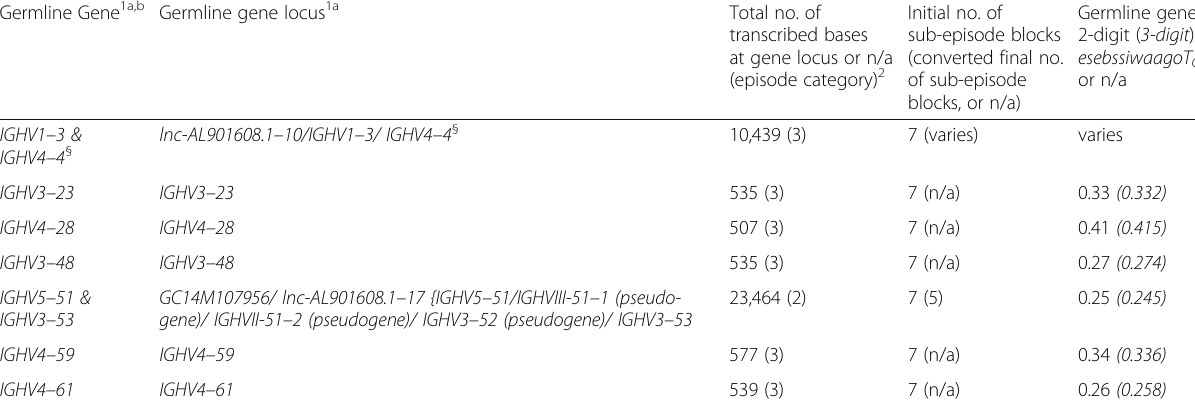
Table 6 Chromosome 14 ( − ) strand chromatin Ig heavy chain locus variability gene esebssiwaagoT Q s for germline genes in